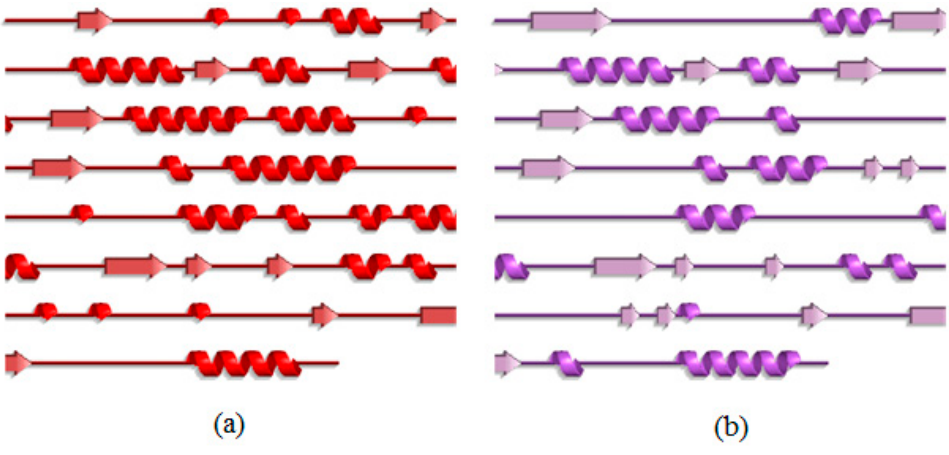
Figure 4. Changes in secondary structure of earth-grown T1 lipase crystal structure before and after 20 ns of simulation: ( a ) Crystal strcuture of earth-grown T1 lipase before simulation; ( b ) Earth-grown T1 lipase after 20 ns of simulation.